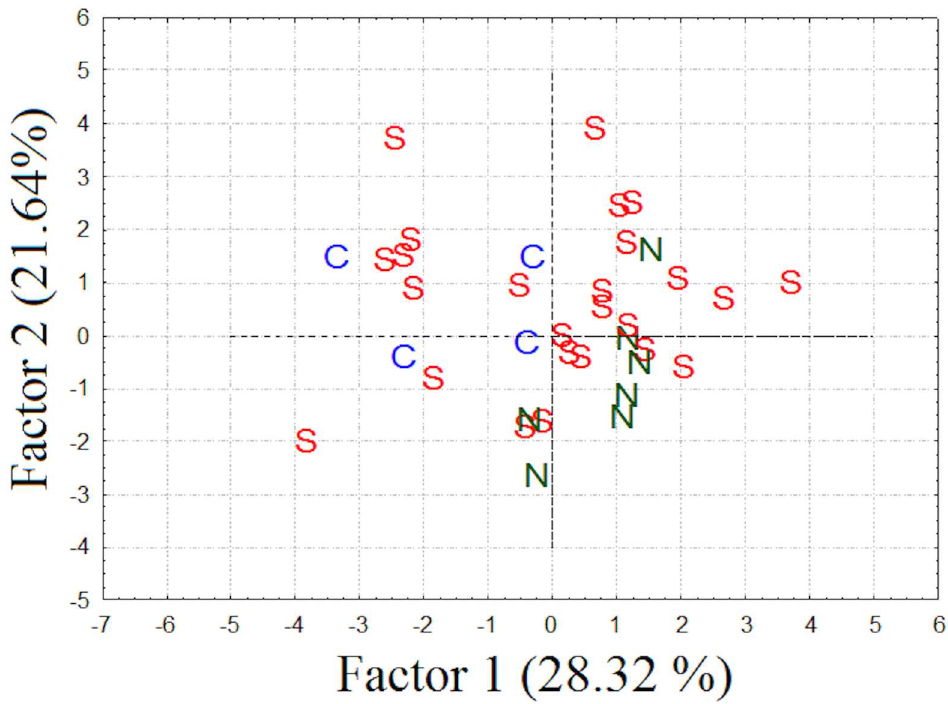
Fig 3. Distribution of individual scores related to phylogeographical clades along the first and second principal components using 12 acoustic properties of the advertisement call of Dendropsophus elegans . The colors and letters correspond to each individual’s phylogeographicalclade (as in [26]): N, northern(green); C, central (blue); and S, southern(red).